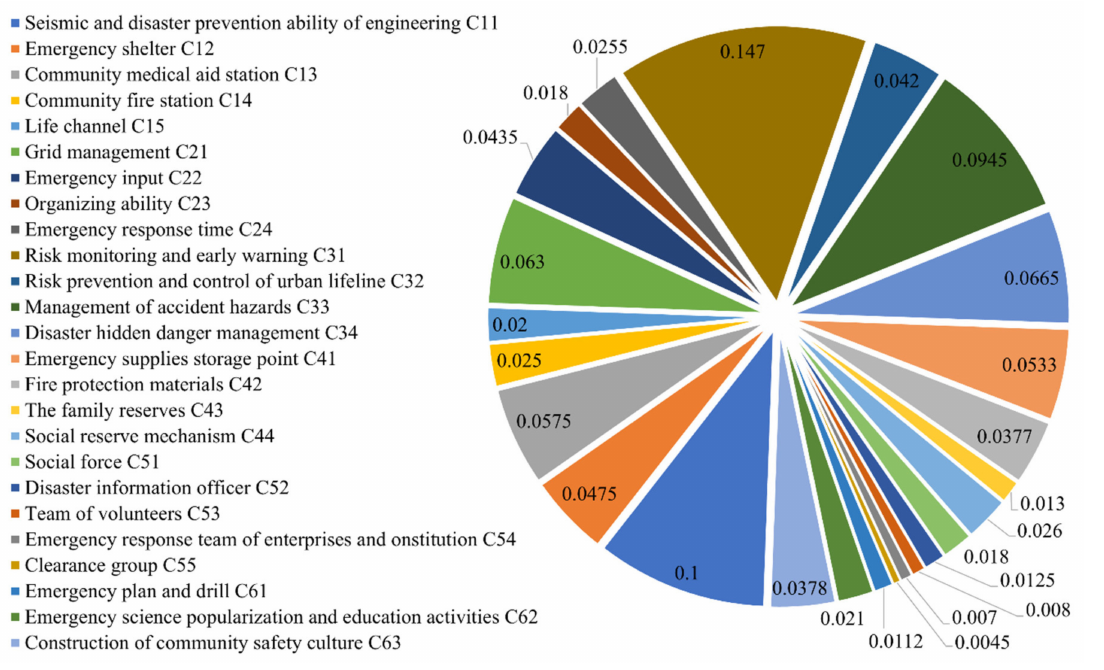
Figure 4. The relative weight of the evaluation